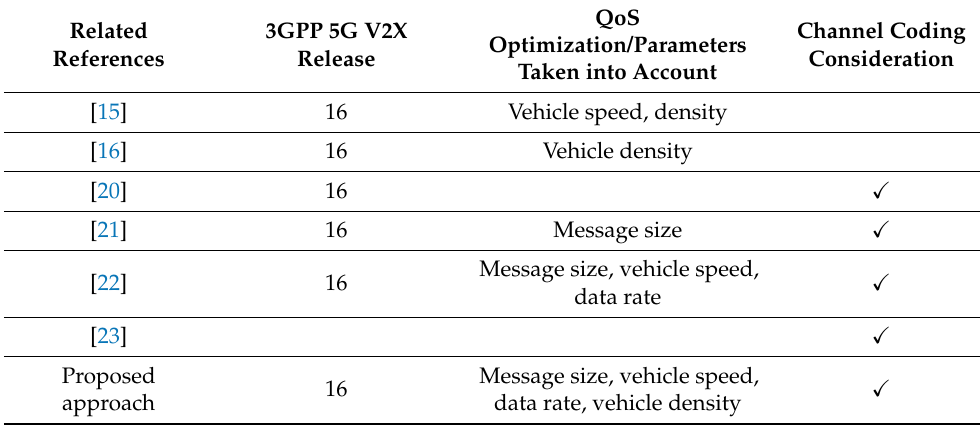
Table 6. Comparison of our proposed approach with published